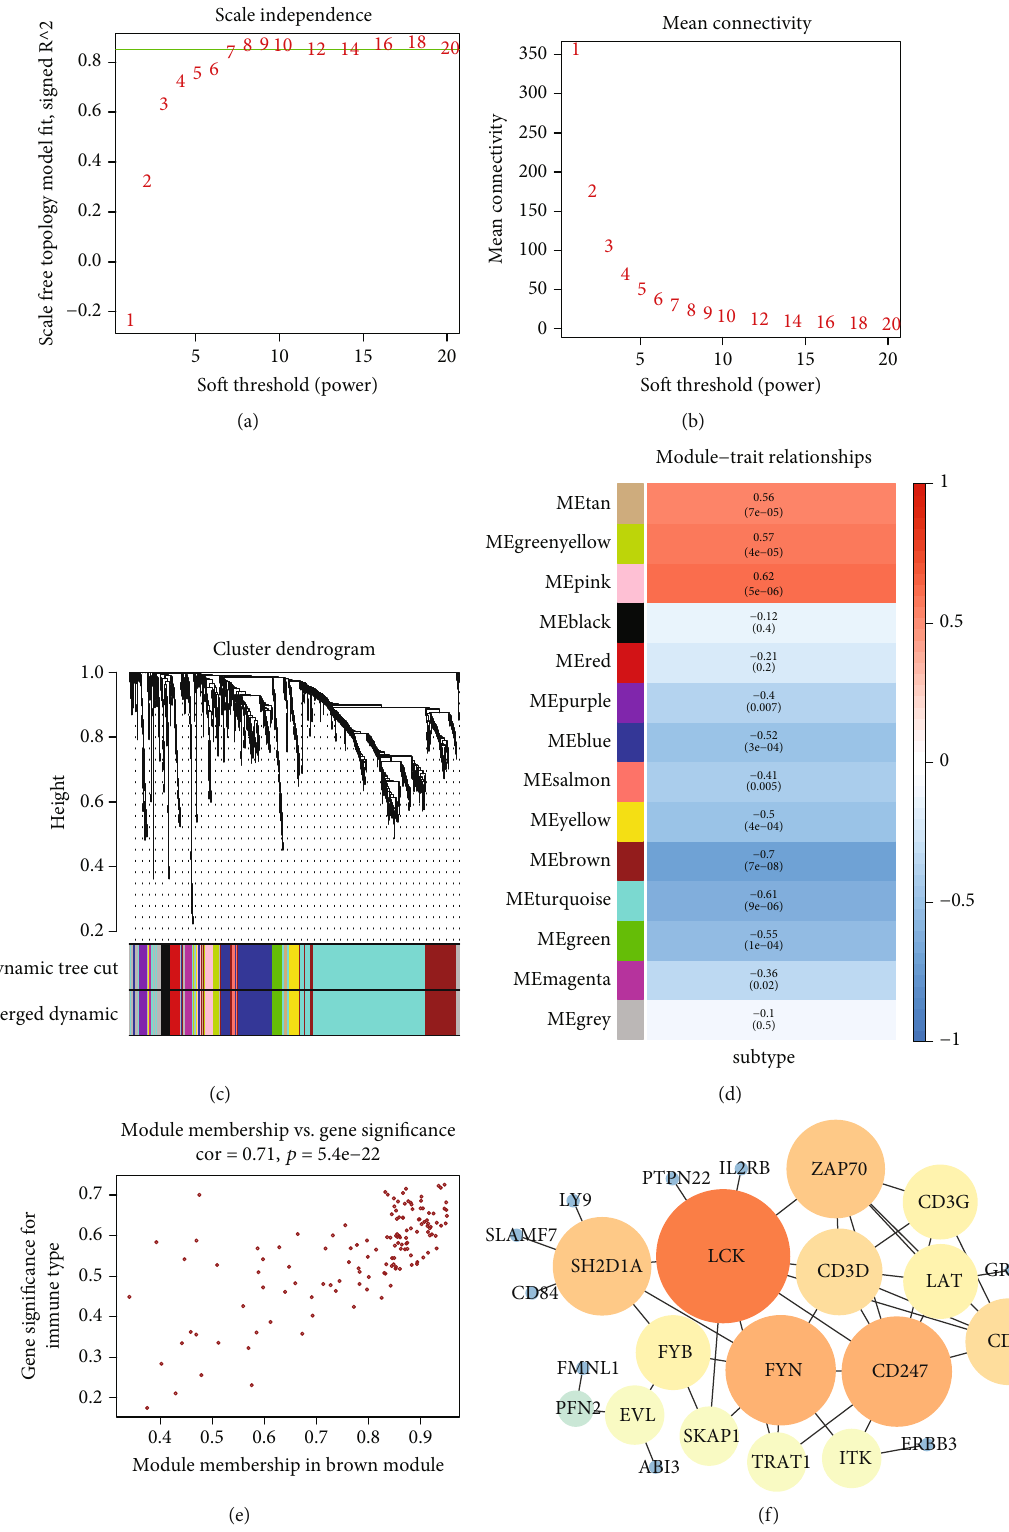
Figure 5: (a) The in fl uence of power values on the scale independence. (b) The in fl uence of power values on the average connectivity. (c) In the cluster dendrogram, each branch indicates one gene, and each color indicates a module. (d) Correlations between the gene modules and NPC subtypes. (e) Scatter diagram for module membership vs. gene signi fi cance in the brown module. (f) The genes from brown module were selected to construct the protein-protein interaction